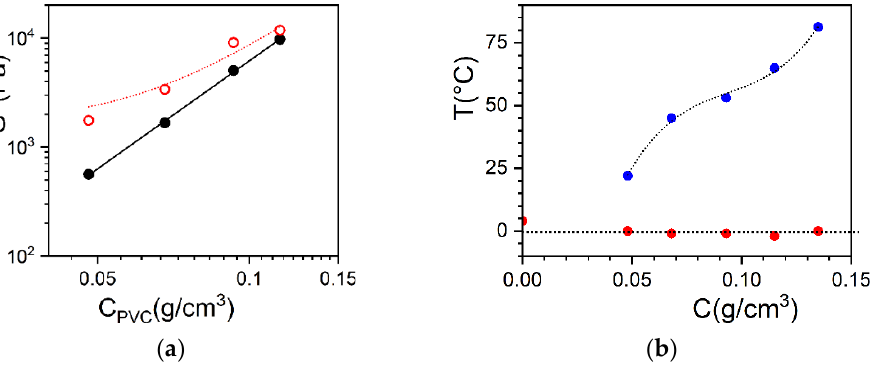
Figure 2. ( a ) Elastic modulus G (cid:48) as a function of PVC concentration; black dots = PVC bi- nary system, red open circles = hybrid gels where the OPVOH concentration is kept constant ( C OPVOH = 0.5 × 10 − 2 g/cm 3 ), unlike the PVC concentration. The red line is a fit with Equation (4). ( b ) Temperature-composition formation phase diagram, where the PVC composition was varied while the OPVOH concentration was kept constant at C OPVOH = 4 × 10 − 3 g/cm 3 . The gelation temperature of PVC was obtained from rheological experiments, while the gelation temperatures of the OPVOH/bromobenzene were obtained using DSC. As can be seen, the PVC network always forms first